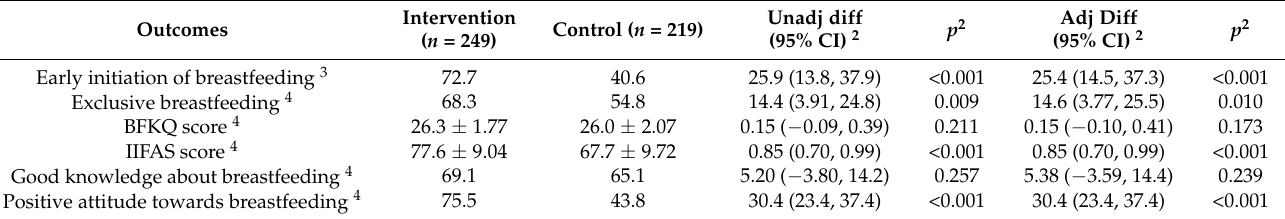
Table 2. Breastfeeding knowledge, attitude, and practices by study arms 1 .